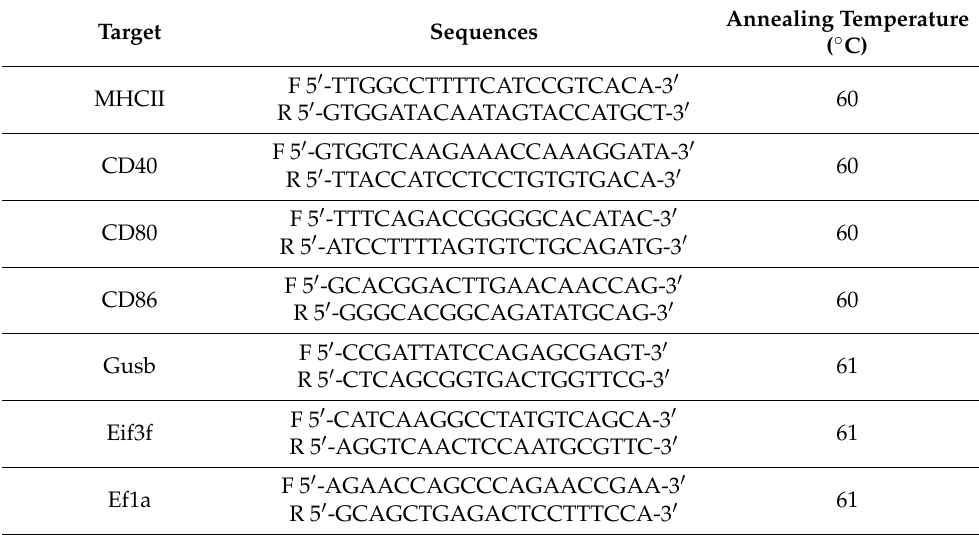
Table 1. Primers used to perform quantitative